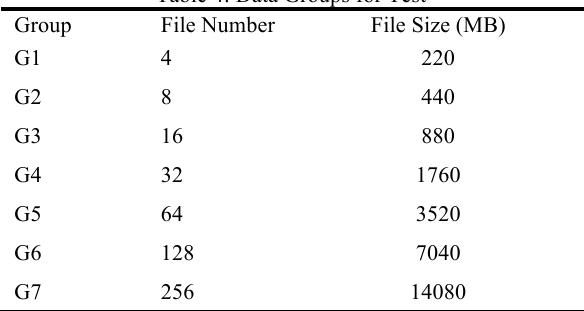
Table 4: Data Groups for Test